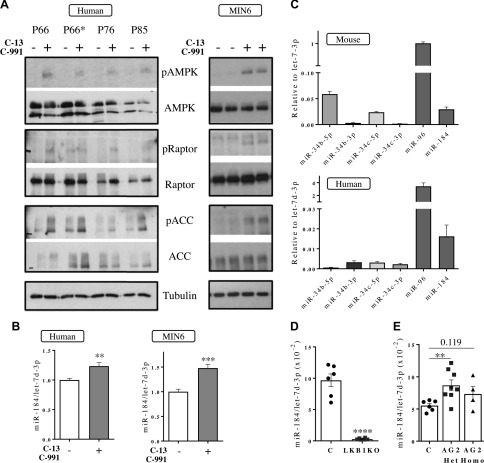
AMPK is both necessary and sufficient for miR-184 expression in mouse and human islets. A) Phosphorylation of AMPK at Thr172 (pAMPK) and its targets Raptor (pRaptor) and ACC (pACC) as well as the total protein (AMPK, Raptor, ACC) was assessed by Western blotting using specific antibodies with extracts from human islets (left side panel) or MIN6 cells (right side panel) treated with AMPK activators C13 (20 μM) and C991 (50 μM) for 24 and 14 h, respectively. P66, P76, and P85 are donor identifiers (see details in Table 1). P66 and P66* correspond to the same donor, but P66* corresponds to islets >100 μm. P66, P76, and P85 islets were all <100 μm. B–E) miR-184 expression was assessed by RT-qPCR in human islets (left hand side, n = 5) and MIN6 cells (right hand side, n = 3) treated with the AMPK activators as in A (B), islets from C57BL/6 mice (upper panel, n = 8–9) and humans without diabetes (n = 7–9) (C), islets from βLKB1KO (LKB1KO) and littermate control (C, black) mice (D), and islets from R299Q γ2 AMPK knock-in mice [heterozygous (AG2 Het) or homozygous (AG2 Homo) for the mutant allele] and littermate controls (C) (E). In D and E, each dot represents islets from a single mouse. Data are expressed as relative to the endogenous control let-7d-3p. In panel B, data are fold-change vs. the untreated sample. **P < 0.01, ***P < 0.001, ****P < 0.0001 (Student’s t test).